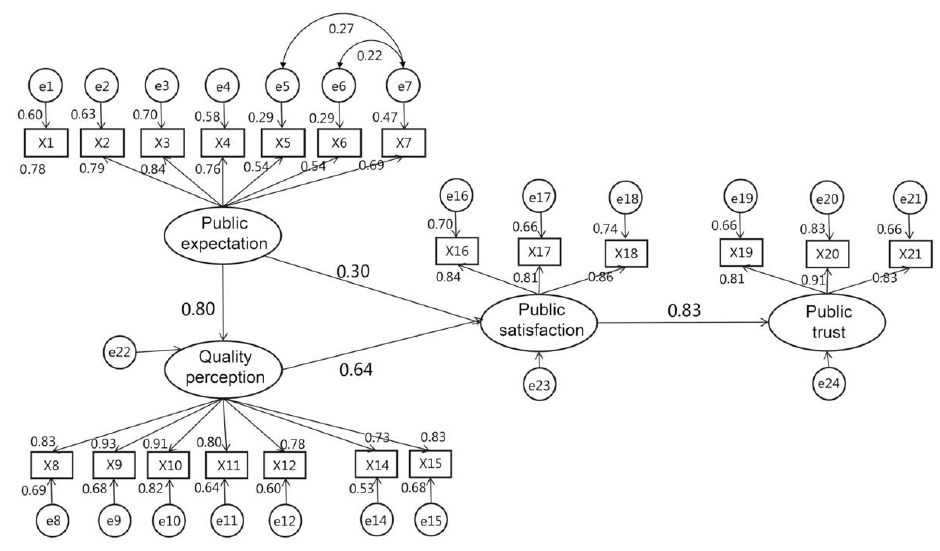
Figure 5. Model results. Table 5. Model estimation